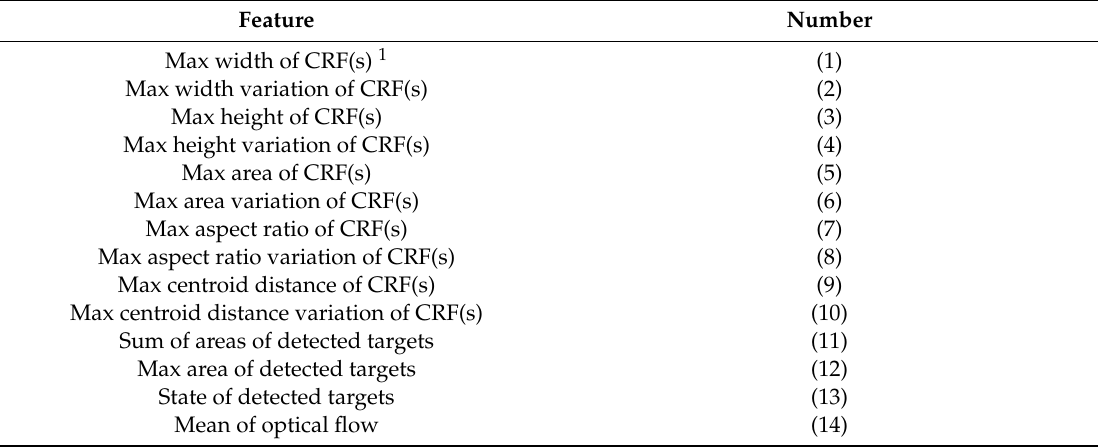
Table 1. Numbering the features.